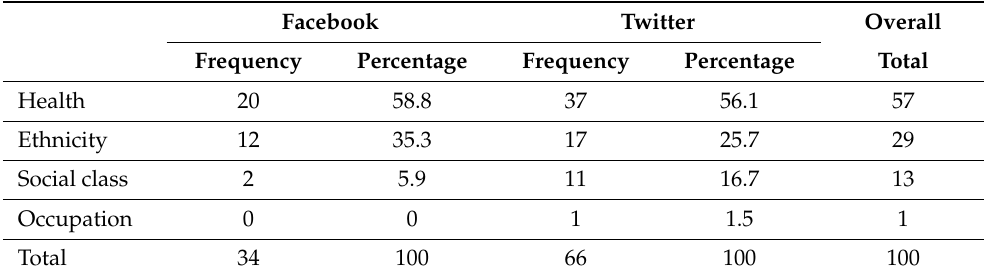
Table 7. Frequency and percentage of types of stigma-marking of COVID-19 patients in Facebook comments and tweets (N =